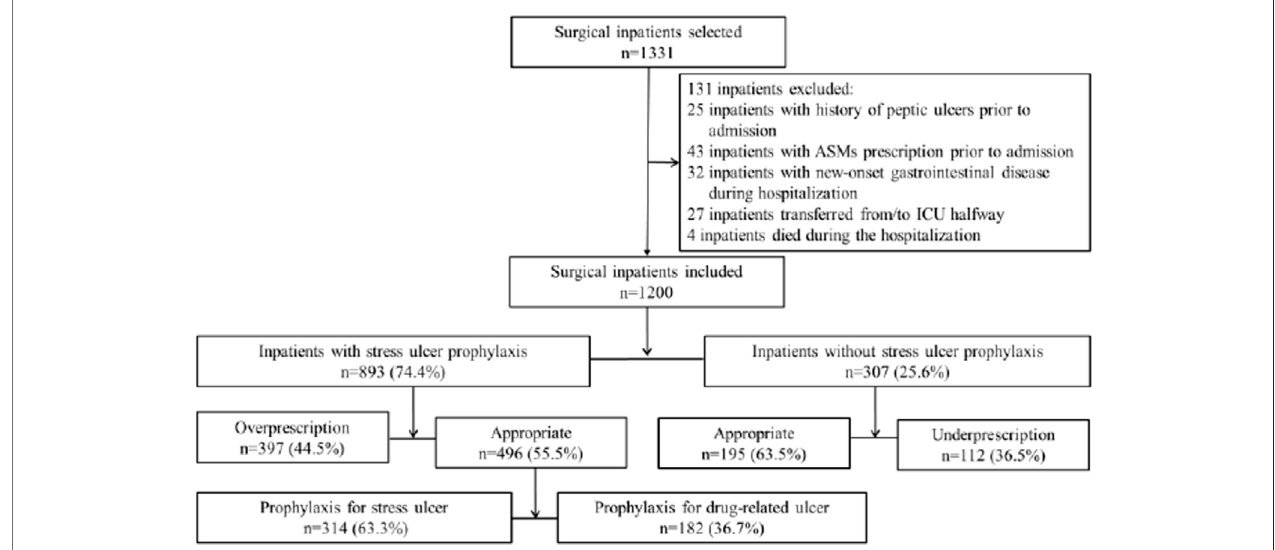
FIGURE1| Flowdiagramdemonstratinginpatientselectionandsubclassi fi cation.Theselectionandsubclassi fi cationprocessfortheinpatientswhoparticipatedin the study is demonstrated. An initial sample size of 1,331 inpatients was selected randomly using a standard computer selection program, and 131 inpatients were excluded according to the criteria determined, and thus 1,200 inpatients were fi nally recruited in this study. The study inpatients were initially divided into subgroups on the basis of SUP prescription receivers or non – SUP prescription receivers, and then categorized into four groups through ascertaining if the indication was in accordance with the criteria determined. The inpatients who received SUP appropriately were subclassi fi ed into two groups according to the criteria determined, of which one met the criteria for SUP indication, while the other met the criteria for drug-induced ulcer prophylaxis.